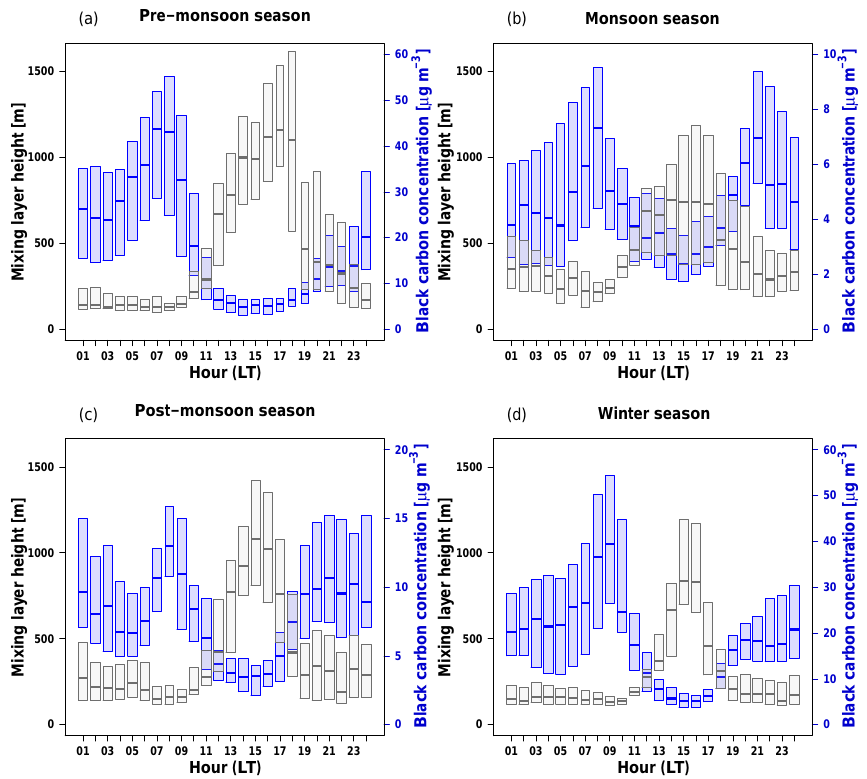
Figure 9. Diurnal cycle of the MLH (grey) and the BC concentration (blue) as a boxplot (showing the median, the upper and lower quantile) for (a) the pre-monsoon (March–May 2013), (b) the monsoon (June–September 2013), (c) the post-monsoon (October–November 2013) and (d) the winter (December 2013–February 2014) season at the Bode